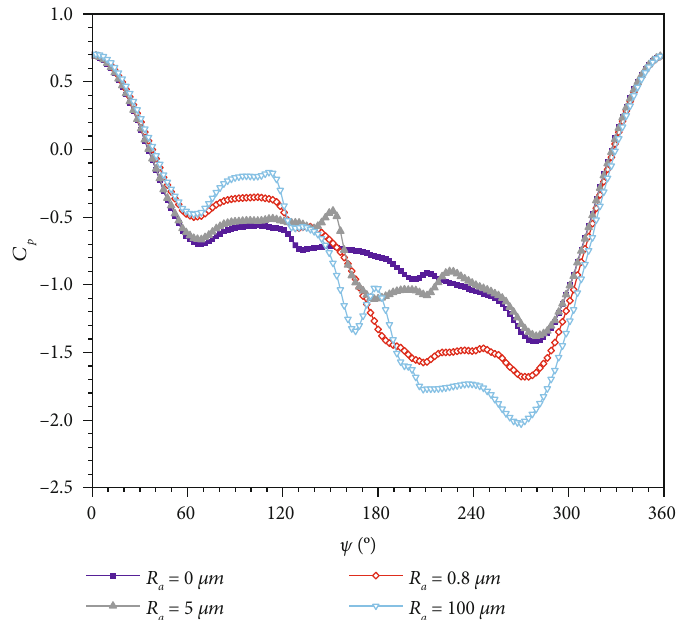
Figure 39: Pressure coe ffi cient distribution of di ff erent models at 6 : 5 D .